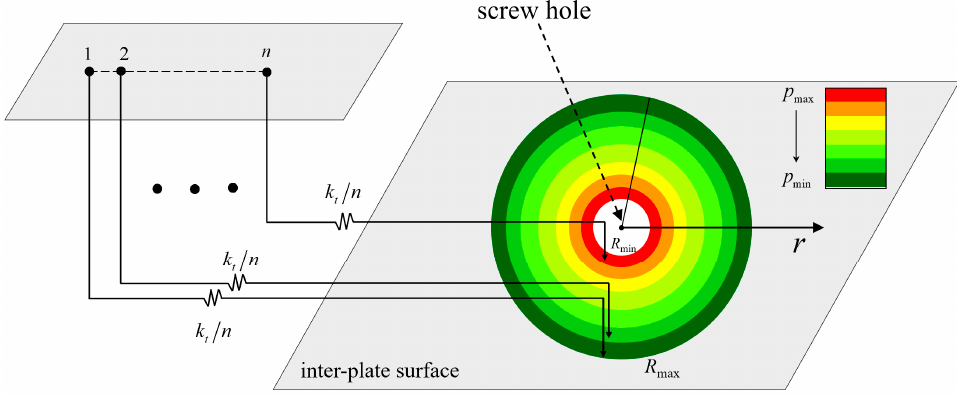
Figure 4. Schematic diagram of the microslip friction modeling approach.